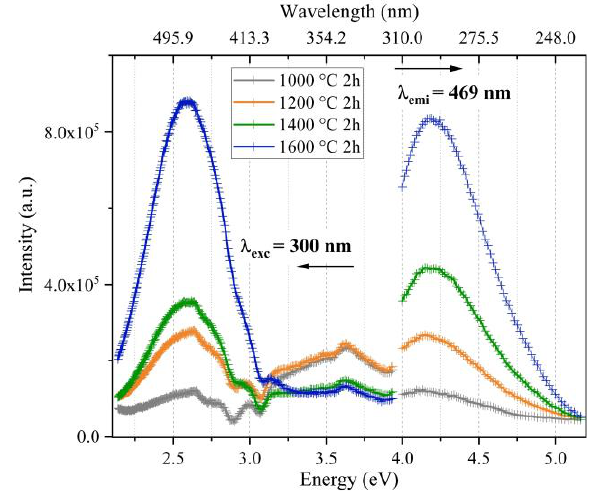
Fig. 3. IRSL spectra for HfO 2 at different temperatures of calcination after 800 Gy of X-rays irradiation. Table . Emission band (eV) for HfO 2 calcined at different